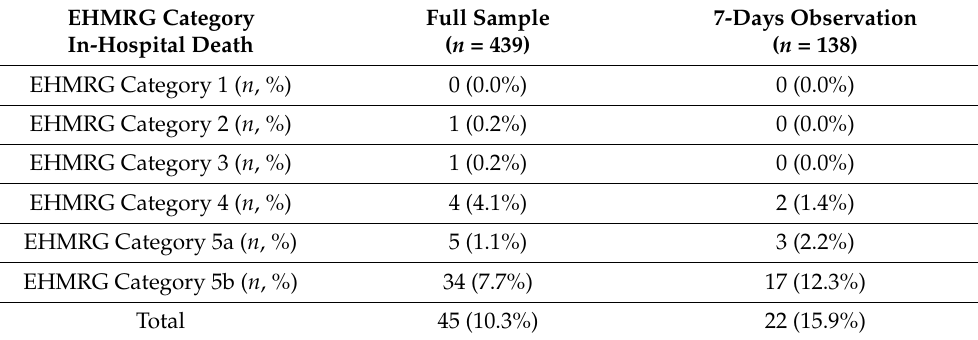
Table 3. Distribution of in-hospital death according to EHMRG score ( p <